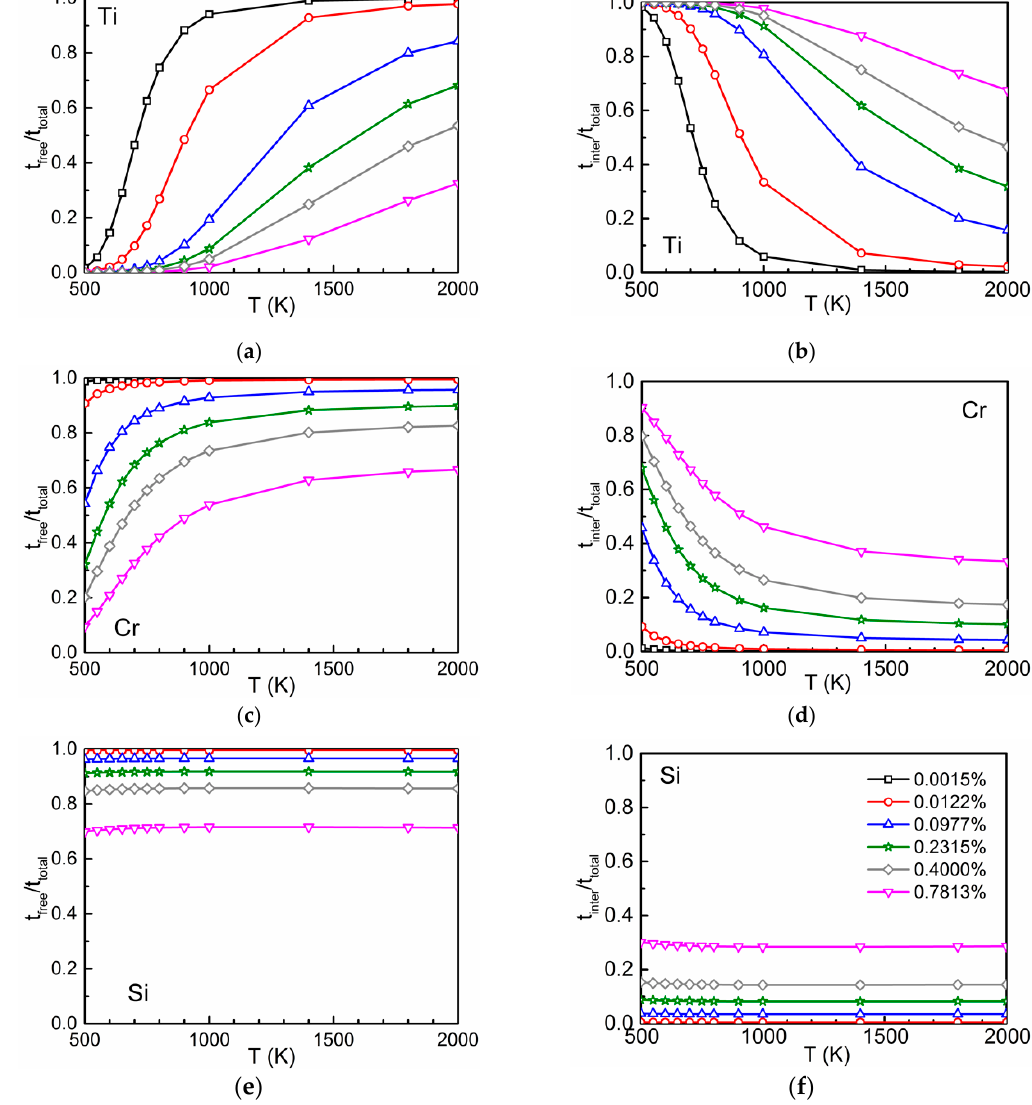
Figure 5. The time ratios t free / t total (left) and t inter / t total (right) in dependence on temperature and concentration for different concentrations of Ti ( a , b ), Cr ( c , d ) and Si ( e , f ).